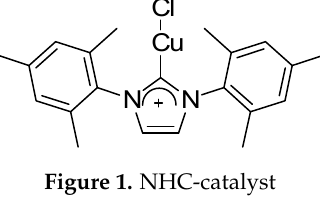
Figure 1. NHC-catalyst